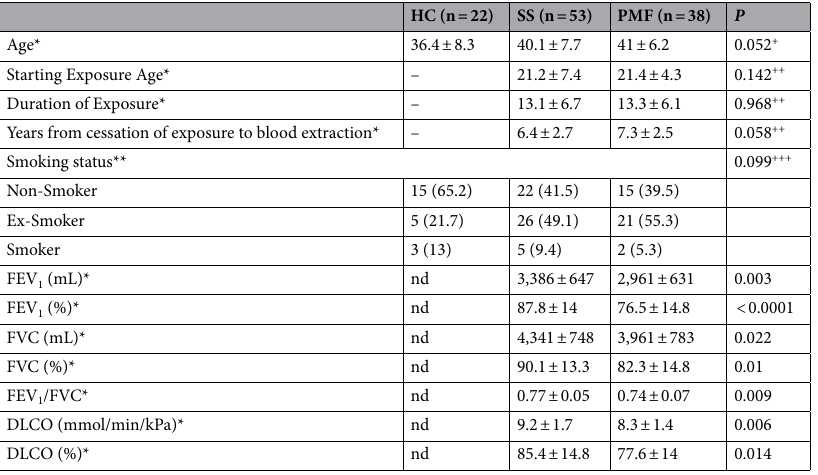
Table 1. Sociodemographic data of participants and pulmonary function values of patients with SS and PMF. Forced expiratory volume in 1 s (FEV1), forced vital capacity (FVC), diffusing capacity of lung for carbon monoxide (DLCO). *Mean ± standard deviation. **Number of cases (percentage). + ANOVA F-test, ++